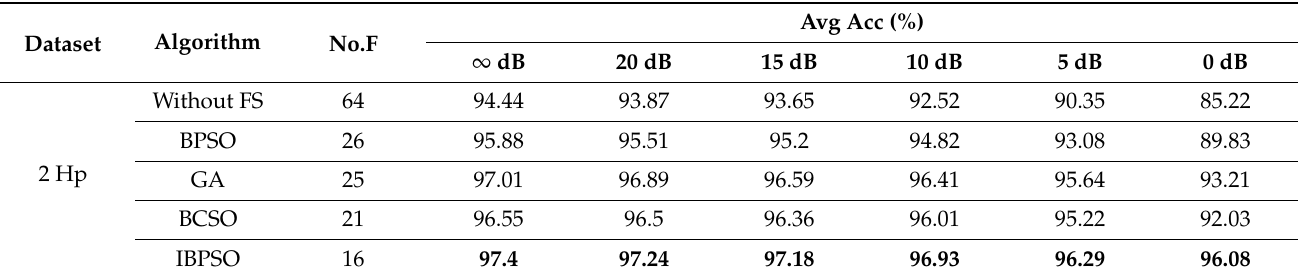
Table 11. Classification results using FCNN-A.